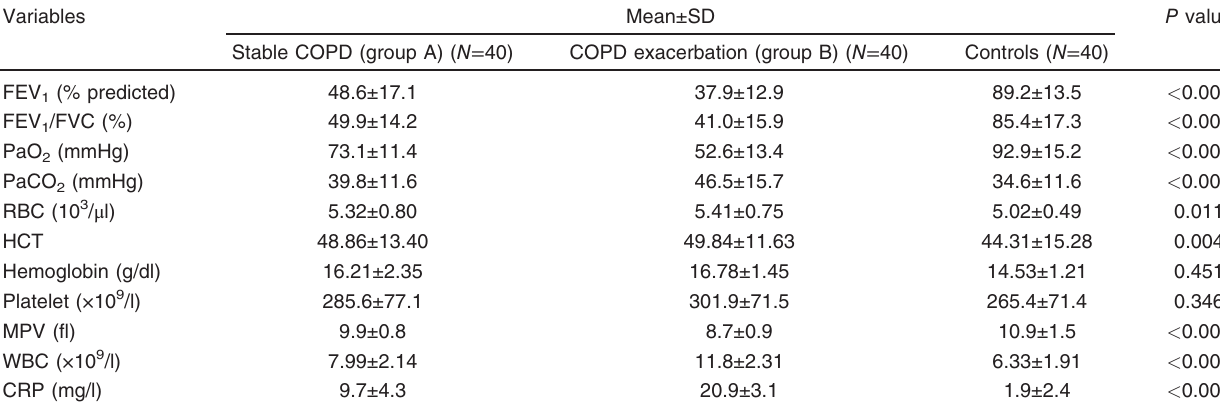
Table 2 Laboratory characteristics among stable, exacerbated COPD patients and controls